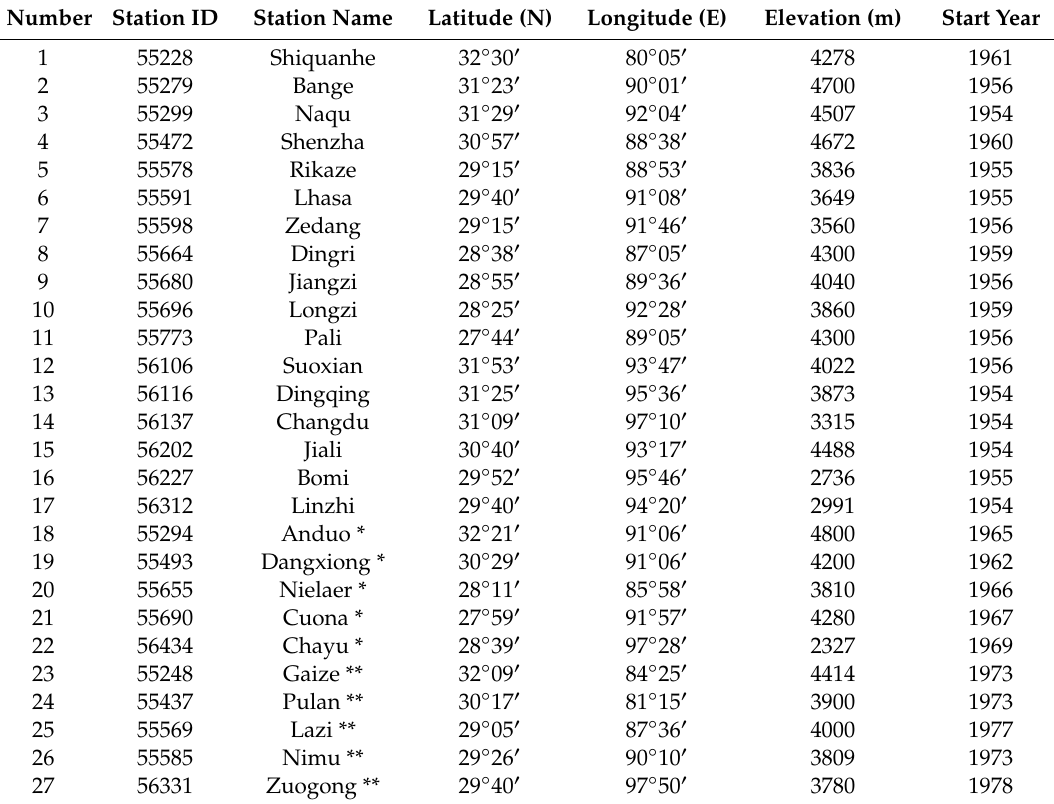
Table A1. Detailed information of the selected meteorological